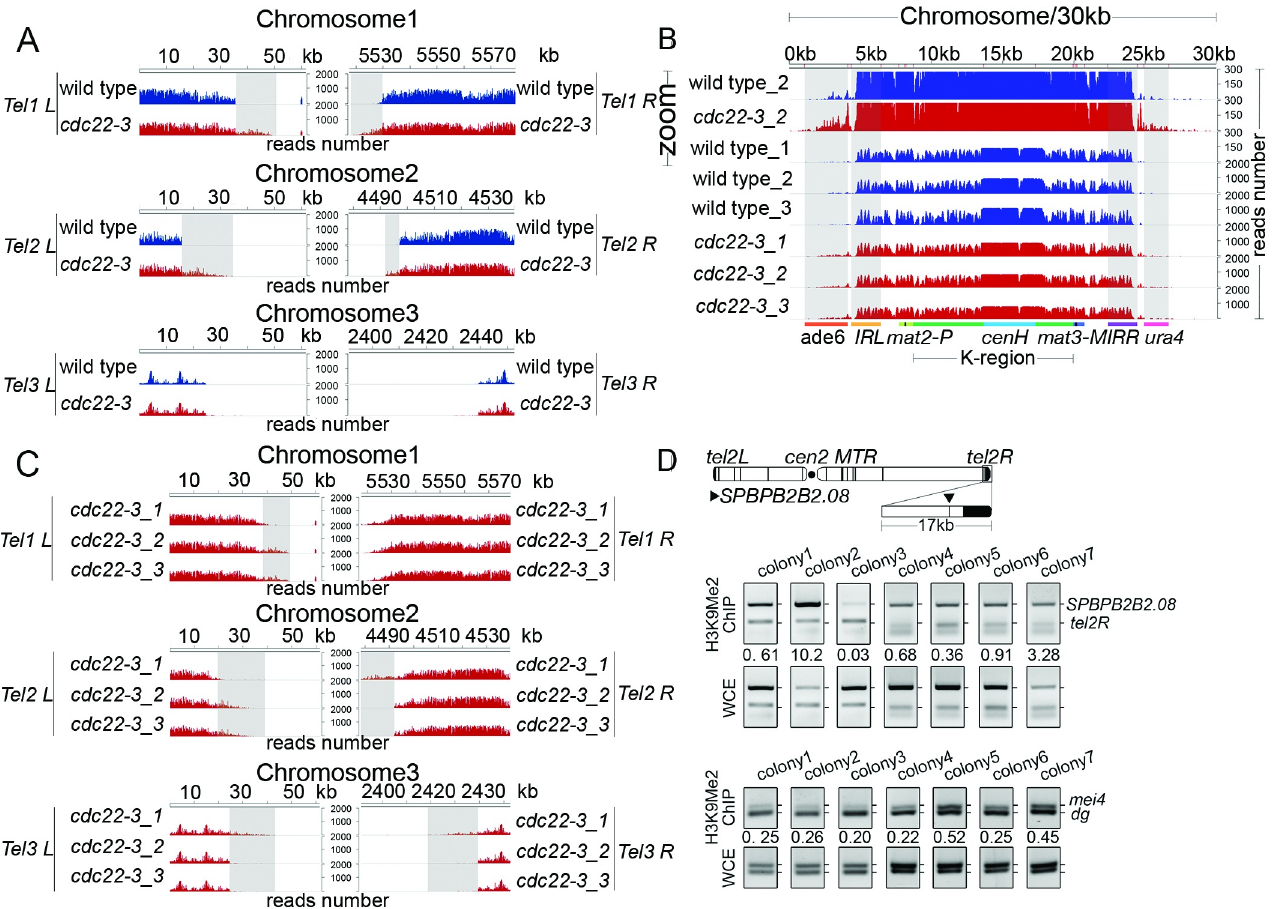
Fig 5. Replication stresspromotes spreading of heterochromatin throughout the yeast genome. (A) H3K9me2 enrichmentDNA reads in wild type and cdc22-3 mutant cells are plotted over sub-telomeric regionof all three chromosomes. Chromosome coordinates are indicatedabove the peaks. Scale bars on the right denote H3K9me2enrichment DNA reads numbers normalized per one million reads. (B) H3K9me2enrichment DNA reads in wild type and cdc22-3 mutant cells were plotted over mating type locus. The location of the ade6 + gene (orange),the IRL repeats (yellow), mat2-P (light green), cenH (blue), the IRR (purple)repeats, and the ura4 + gene (pink) are indicatedbelowthe DNA peaks. Shadedareas highlightthe ade6 + , IRL , IRR and ura4 + genes. (C) H3K9me2enrichment DNA reads in three biological cdc22-3 mutant cells were plotted over sub-telomeric regionof all three chromosomes. Chromosome coordinatesare indicatedabovethe peaks. Scale bars on the right denote H3K9me2enrichment DNA reads numbers normalized per one million reads. (D) Multiplex PCR is performed on immune-precipitated DNA from 7 independent yeast coloniesof cdc22-3 mutant to amplify a fragment from the gene ( SPBPB2B2 . 08 ) nearbysub-telomere right regionin chromosome II, as well as a fragment from tel2R locus. For the normalization control, PCR is performed in parallelfrom non-immunoprecipitated DNA (WCE panel). The numbers shown are calculatedby the gray value of PCR product from ChIP samples dividedby the gray value of that from WCE samples.